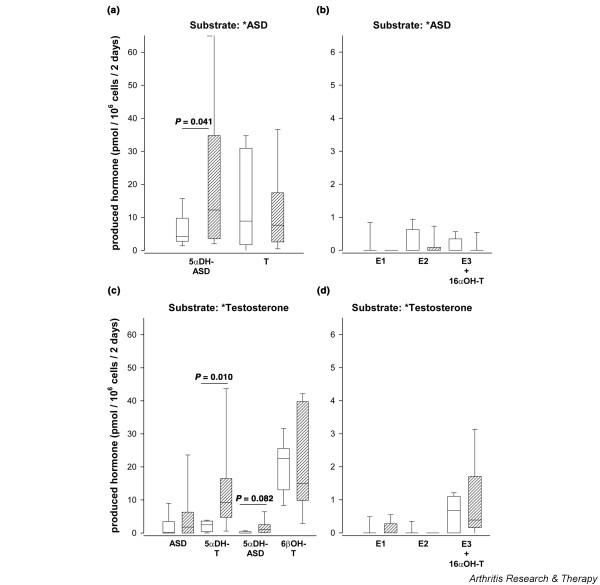
Conversion of ASD and testosterone into downstream steroid hormones in mixed synovial cells. (a,b) Spontaneous conversion of radiolabeled ASD into downstream metabolites in OA (open bars, n = 23) and RA patients (hatched bars, n = 19). (c,d) Spontaneous conversion of radiolabeled testosterone into downstream metabolites in OA (open bars, n = 10) and RA patients (hatched bars, n = 9). All panels: the E3 and 16αOH-testerone produced are given in one bar because only one spot was detected for both steroids using TLC. Values are given as pmol/106 cells/48 hr as box blots with the 5th, 25th, 50th (median), 75th, and 95th percentile when applicable. * Denotes radiolabeled substrate. OA, osteoarthritis; RA, rheumatoid arthritis. Other abbreviations are as given in the legend to Fig. 1.